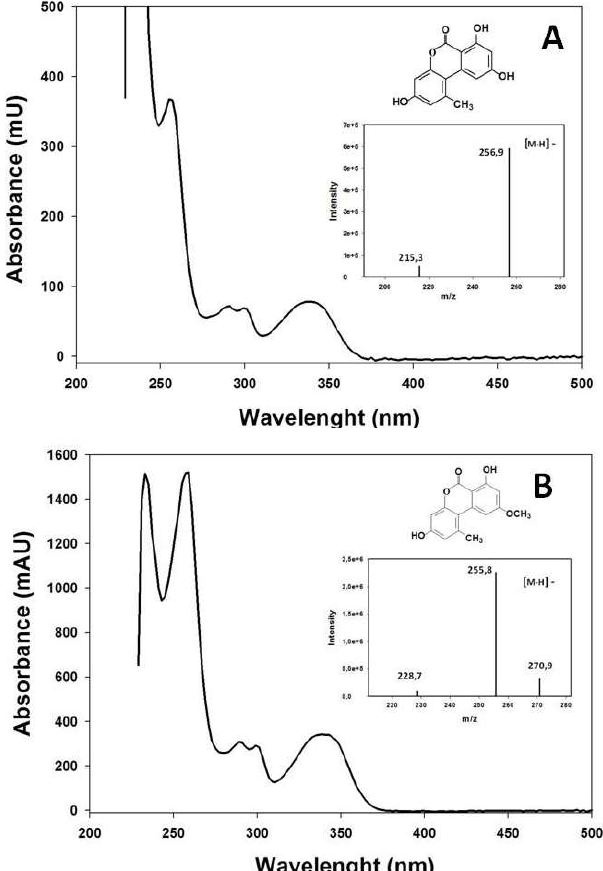
Figure 3. UV/Vis absorbance and mass spectra of alternariol ( A ) and alternariol monomethyl ether ( B ) mycotoxins isolated from 15 day-old A. alternata mycelia (Alt14 isolate).